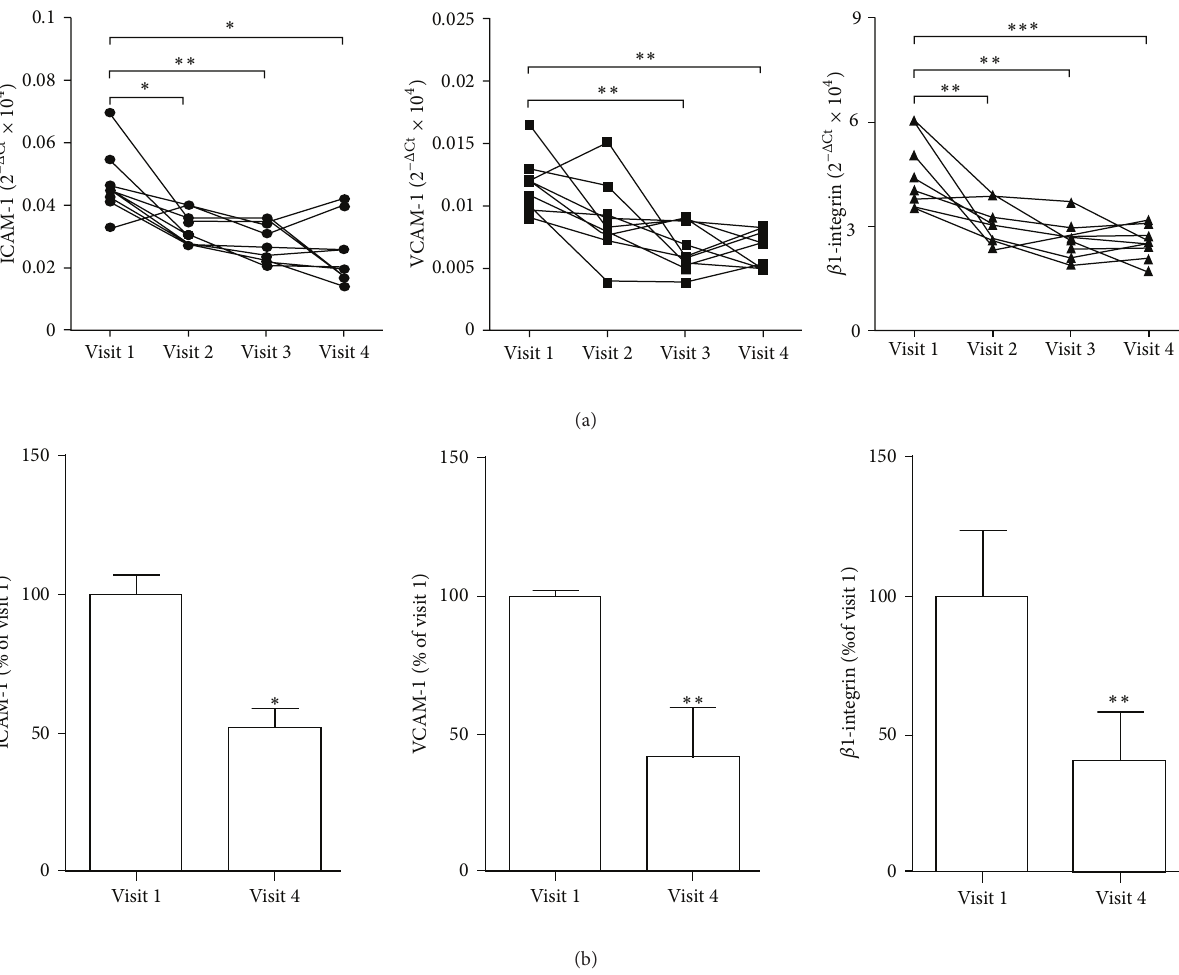
while reduction in expression for VCAM-1 was significant from visit 3. The % reduction for all molecule tested at visit 4 with respect to visit 1 varied from 41% to 50% (Figure 1(b)). No difference was observed in AM mRNA levels in EC between patients on atorvastatin 10 or 80 mg/day and no relationship was found between AM mRNA expression and lipid profile or hs-CRP (data not shown).